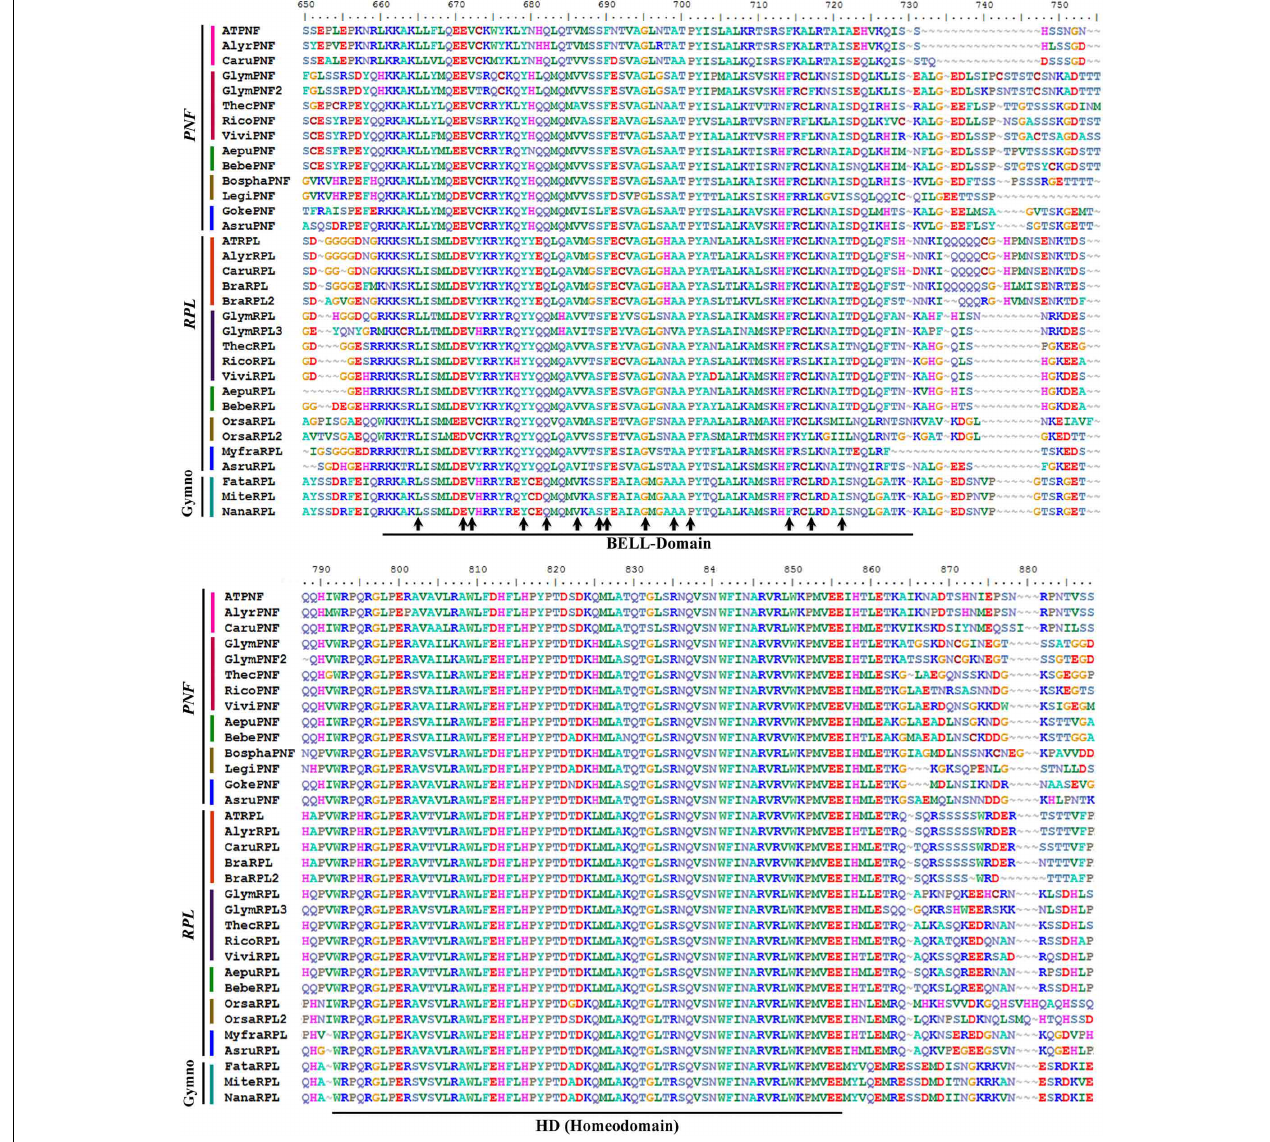
invariant amino acids (arrows) in all gymnosperm and angiosperm RPL/PNF, important for dimerization that include L5, E11, V12, Y19, Q22, V26, S29, F30, G35, A40, P42, F55, L58, I62. The Homeodomain (HD) is very conserved (85%) with 53 AA conserved in seed plants out of 62 aminoacids total in the domain. Domains were drawn based on Mukherjee et al.